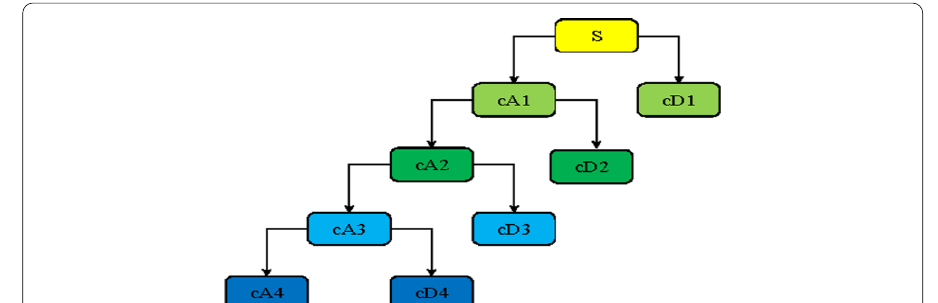
Fig. 6 Schematic diagram of four-layer wavelet decomposition